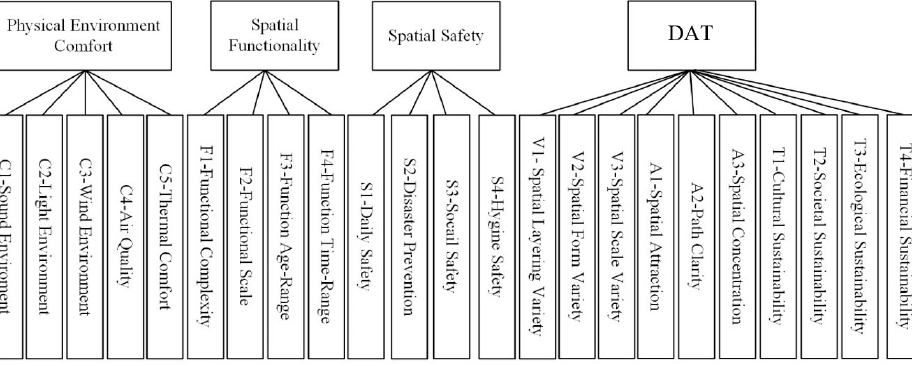
Table 5. Correlation Analysis.